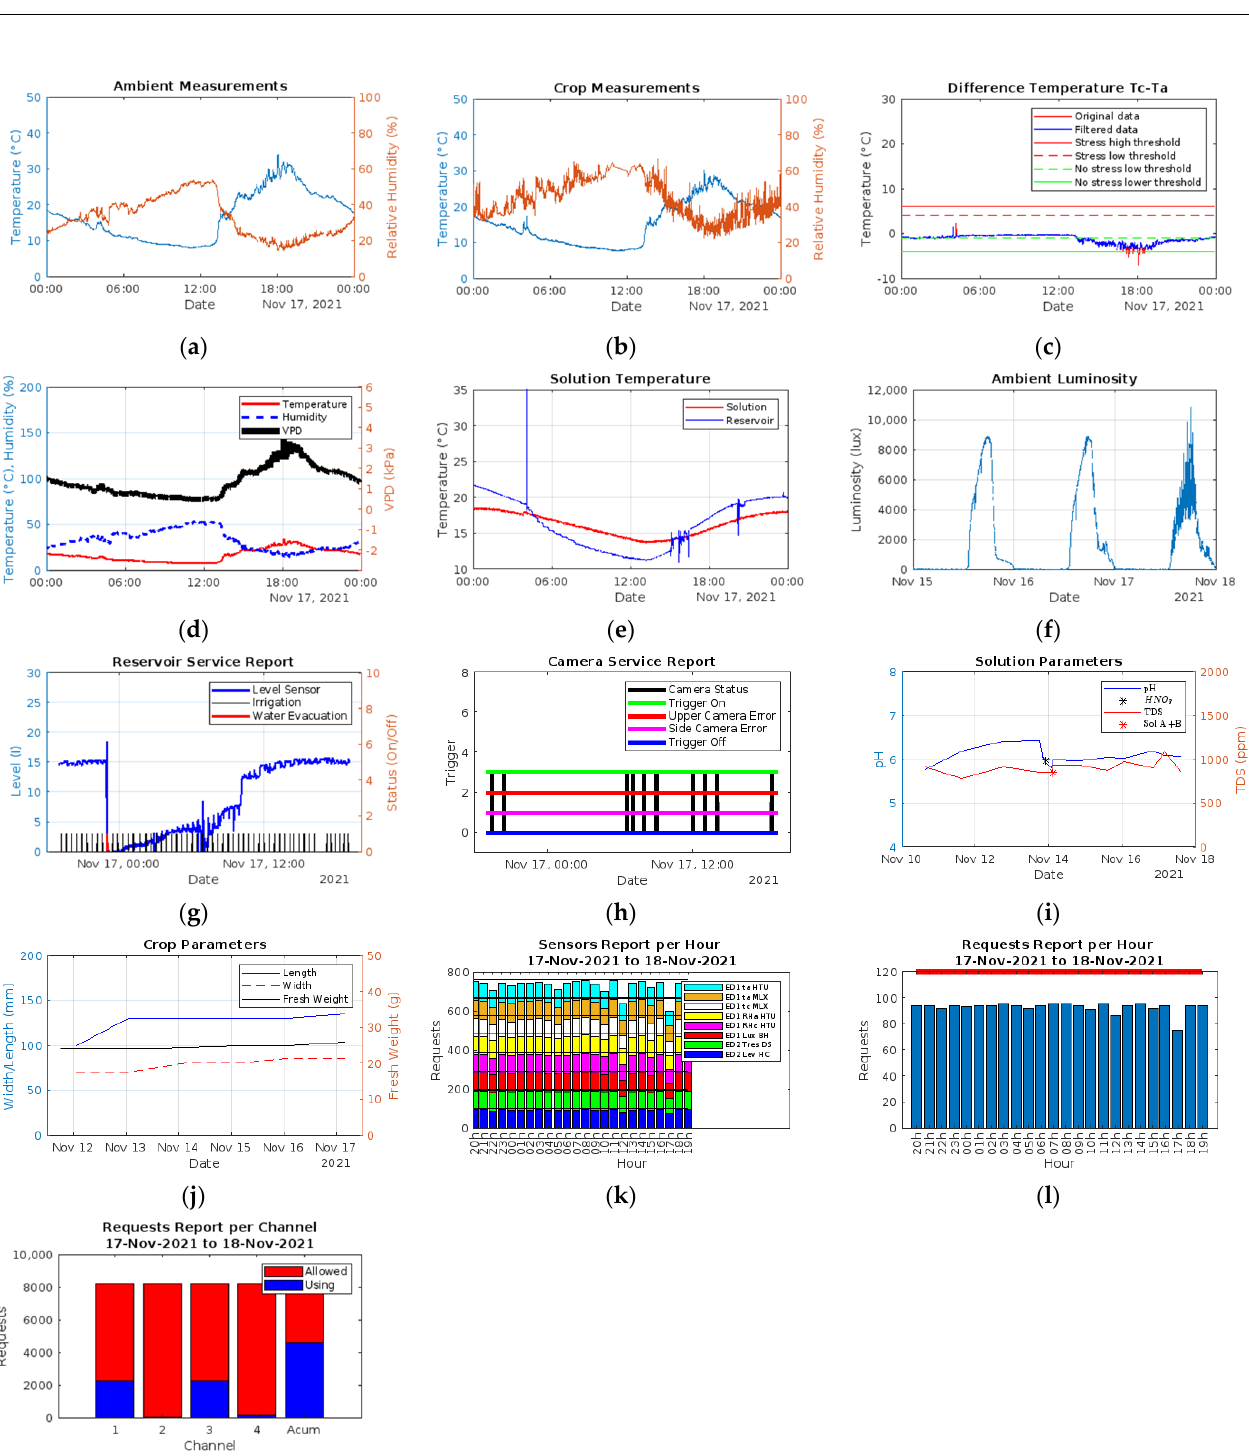
Figure 9. Reports generated by Thingspeak using MATLAB visualizations. ( a ) Temperature measurement in solution tanks; ( b ) measurement of temperature and relative humidity in crop; ( c ) crop minus environment; ( d ) vapor pressure deficit; ( e ) temperature in tanks; ( f ) ambient luminosity; ( g ) report of the level of the recirculation tank and performance of irrigation and recirculation systems; ( h ) operation state of the imaging system; ( i ) parameters in nutrient solution pH and EC; ( j ) crop growth parameters; ( k ) report of successful readings on sensors per hour; ( l ) reporting of requests sent to the server by hour; ( m ) reporting of requests sent to the server by